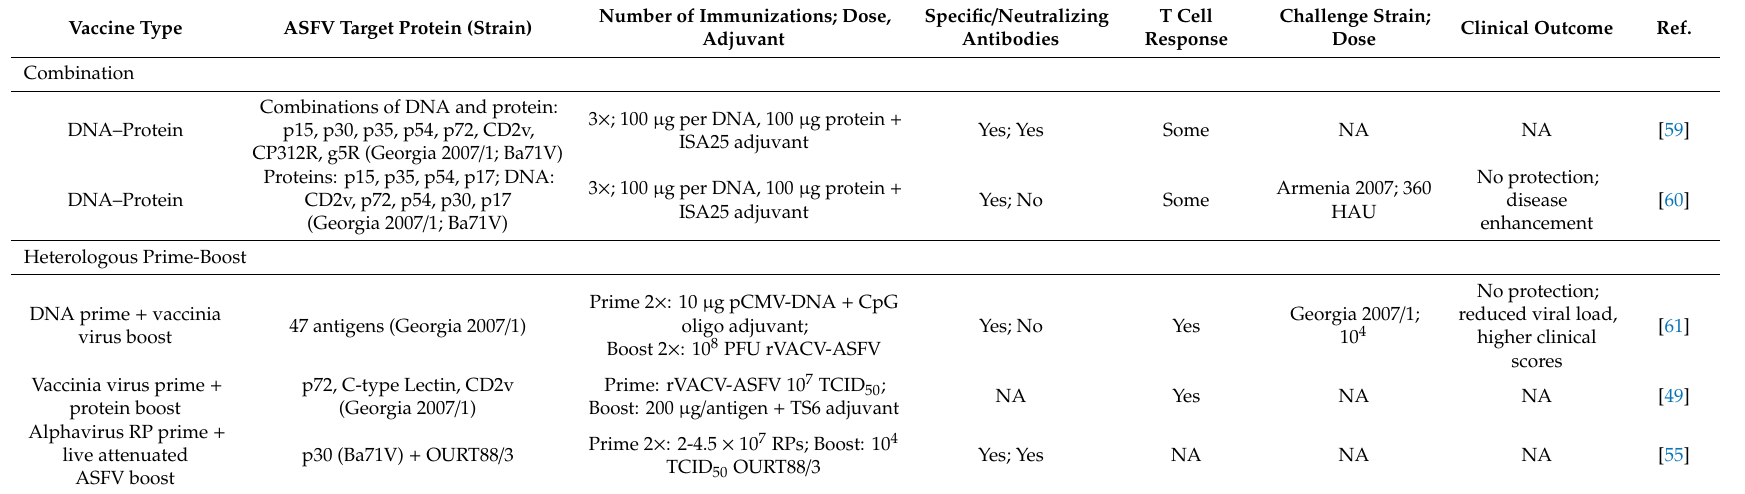
Table 4. Combination and heterologous prime-boost ASFV vaccine